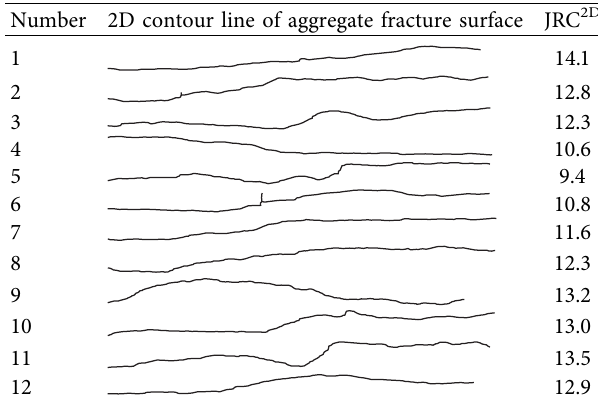
Table 7: 2D roughness of contour lines along the circumference.